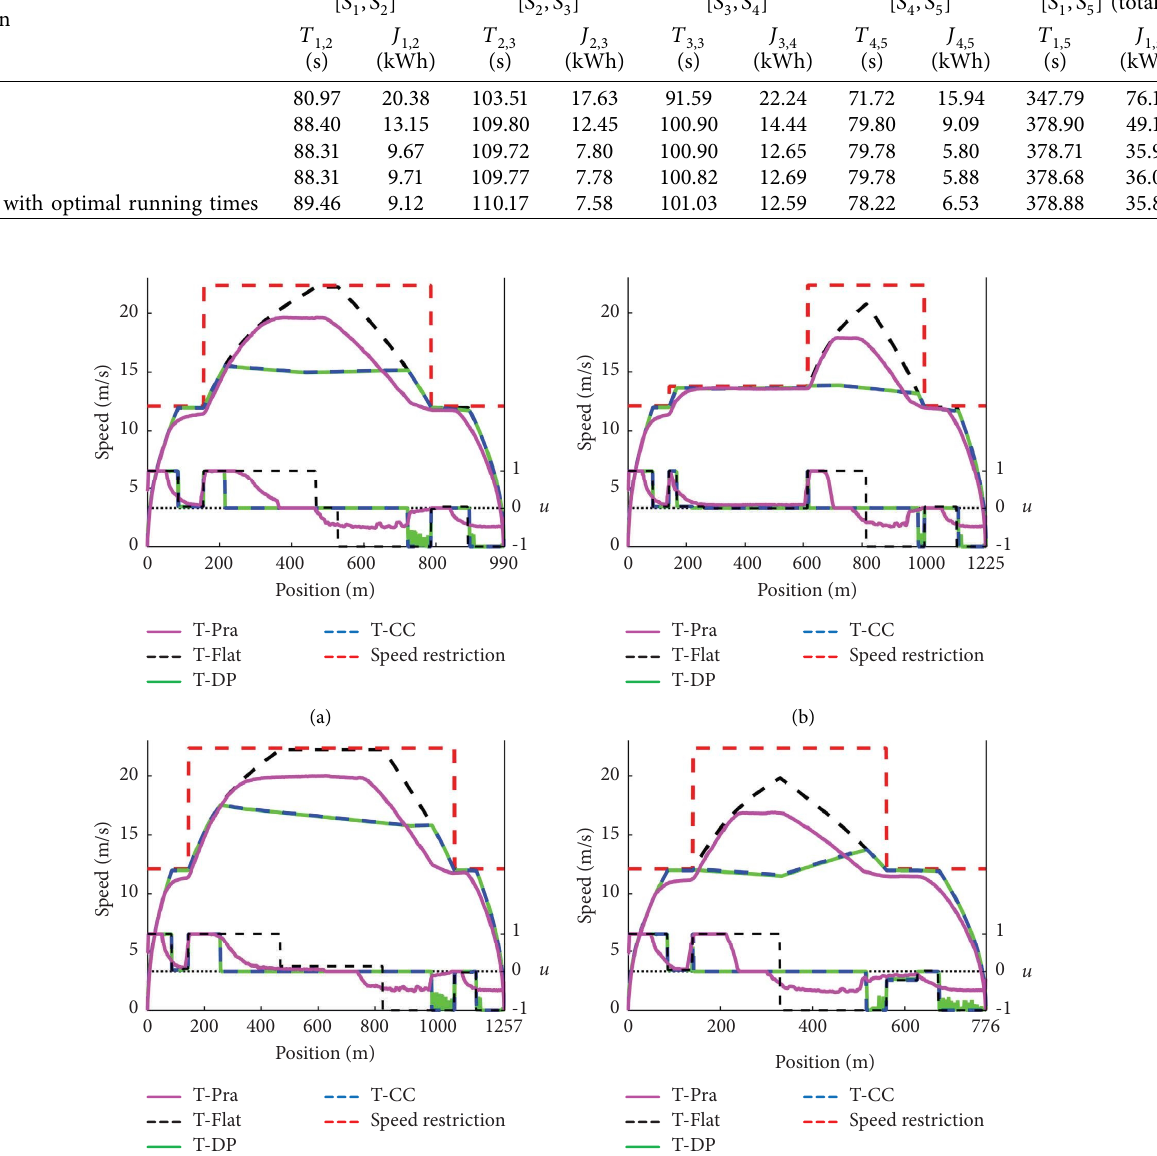
Table 4: Te comparison of diferent trajectories and running time distribution schemes from S